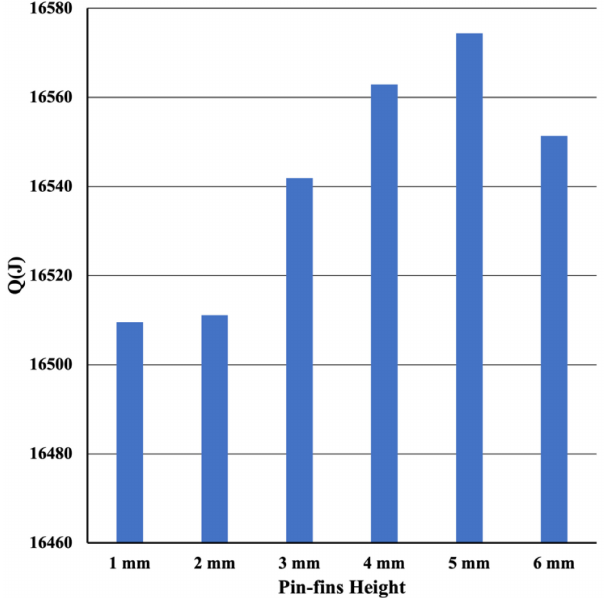
Figure 15. Energy stored (Q) as a function of pin-fins height (Re =